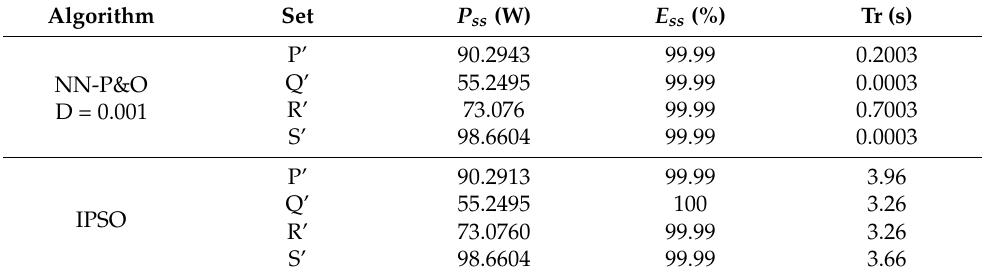
Table 4. Performances comparison between NN-P&O and IPSO under shading.